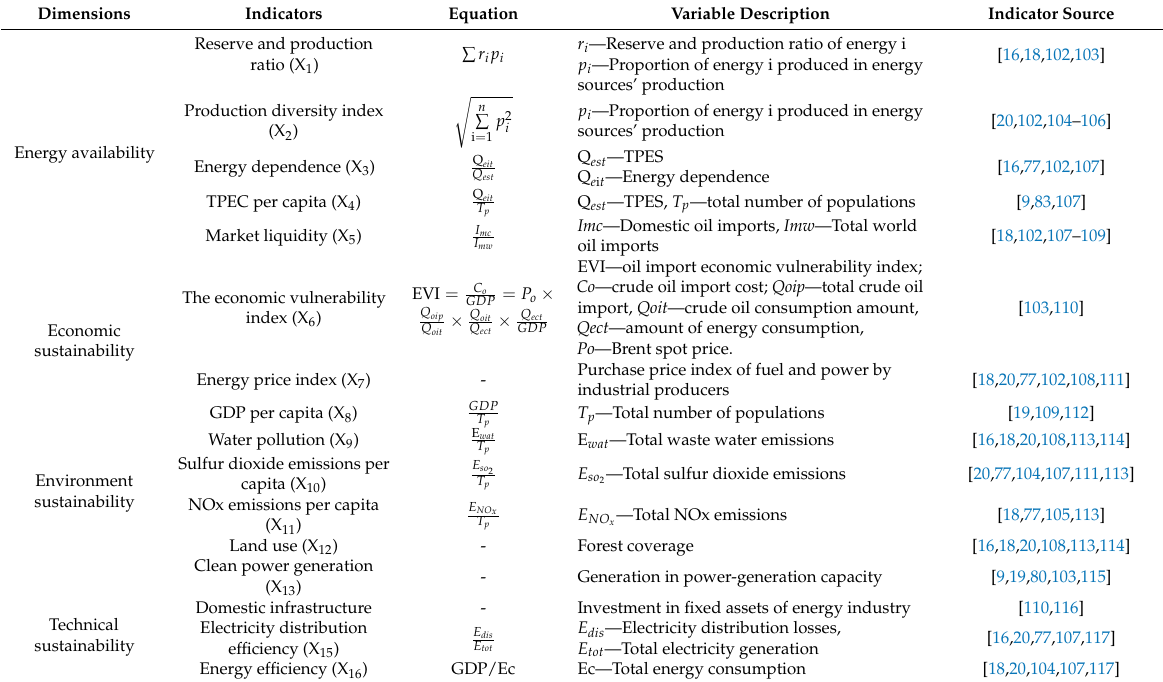
Table 3. Indicators for the energy supply sustainability